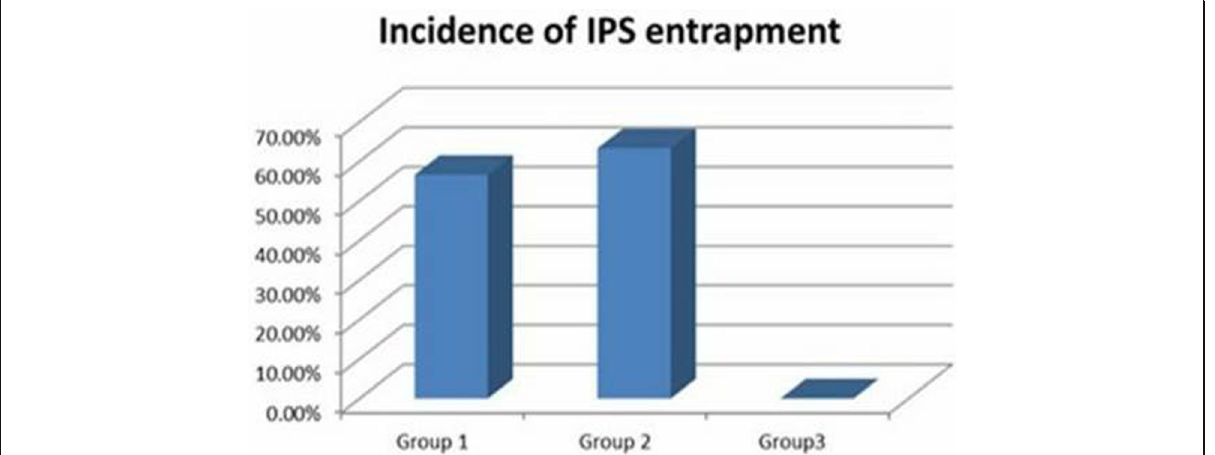
Fig. 6 Our clinical and electrophysiological study revealed the incidence of infrapatellar neuropathy among patients of the study groups as 56% in the first group, 63% of the second group and 0% in the third